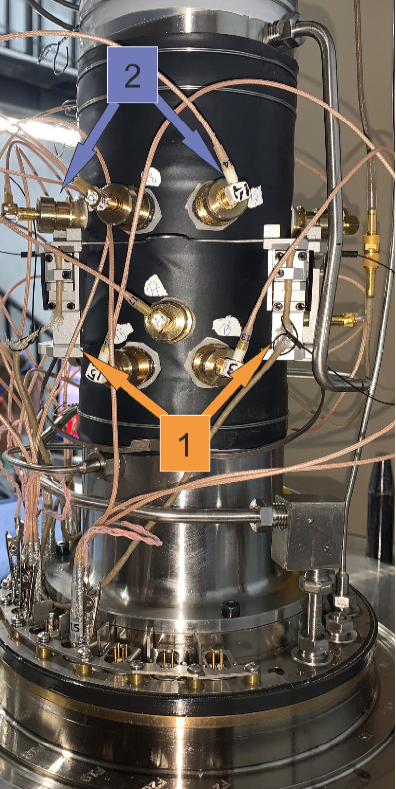
Figure 3. A granite specimen prepared for a test with an extensometer (1) installed, AE sensors (2) glued onto the cylindrical surface.